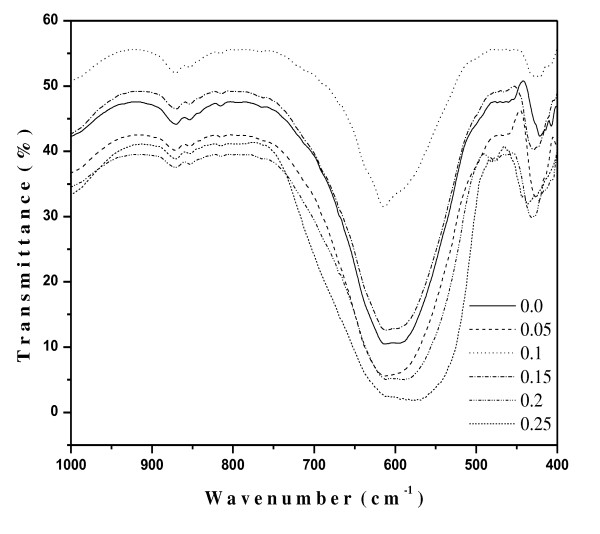
FTIR spectra of Ni0.7-xZnxCu0.3Fe2O4 (0.0 ≤ x ≤ 0.2, x = 0.05) ferrite nanoparticles.